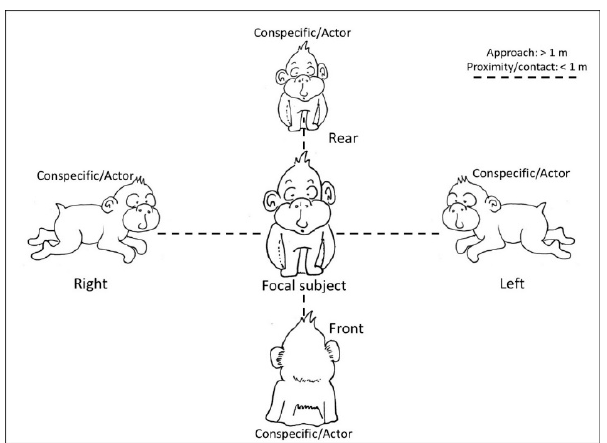
Figure 1. Schematic representation of the interactions considered in the current study. We recorded whether macaques (conspecific/actors) were in the left or right visual field of the focal subject or whether they were in front or on the rear of the focal subject during social interactions (approaches, proximity, and social contact such as grooming and embraces).